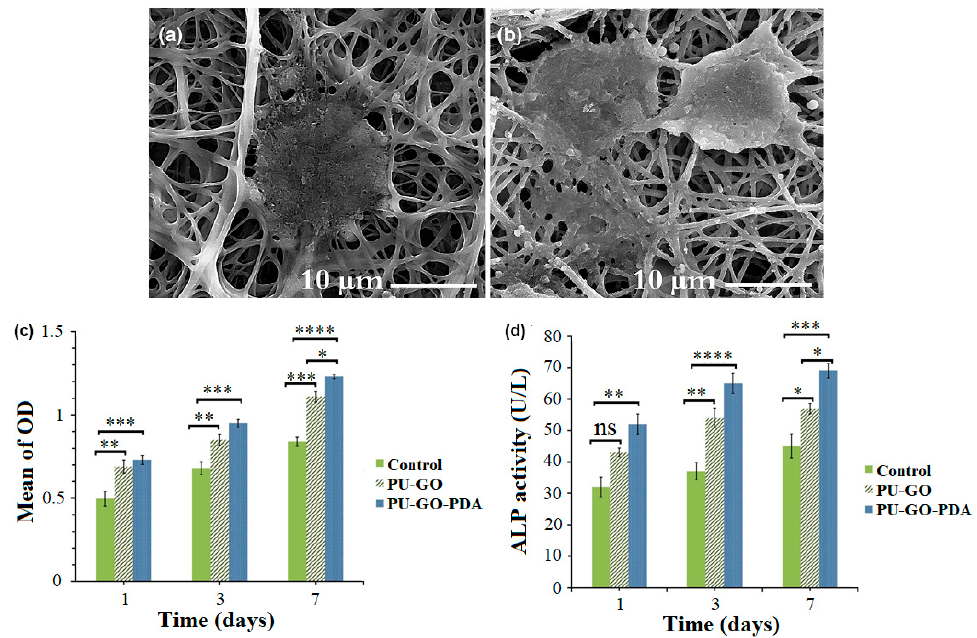
Figure 15. Field emission scanning electron microscopy micrographs of MG-63 (human osteosarcoma) cells attachment on GO-PDA ( a ) and PU-GO-PDA ( b ) fibrous scaffolds after 24 h. ( c ) Cell proliferation of MG-63 cells cultured in the presence and the absence of PDA, for 1, 3, and 7 days (* p < 0.05, ** p < 0.005, *** p < 0.0005, **** p < 0.00005). ( d ) alkaline phosphatase (ALP) activity of MG-63 cultured in the presence or absence of PDA, for 1, 3, and 7 days (* p < 0.05, ** p < 0.005, *** p < 0.0005, **** p < 0.00005). Reproduced with permission from [130]. Copyright John Wiley and Sons, 2019.